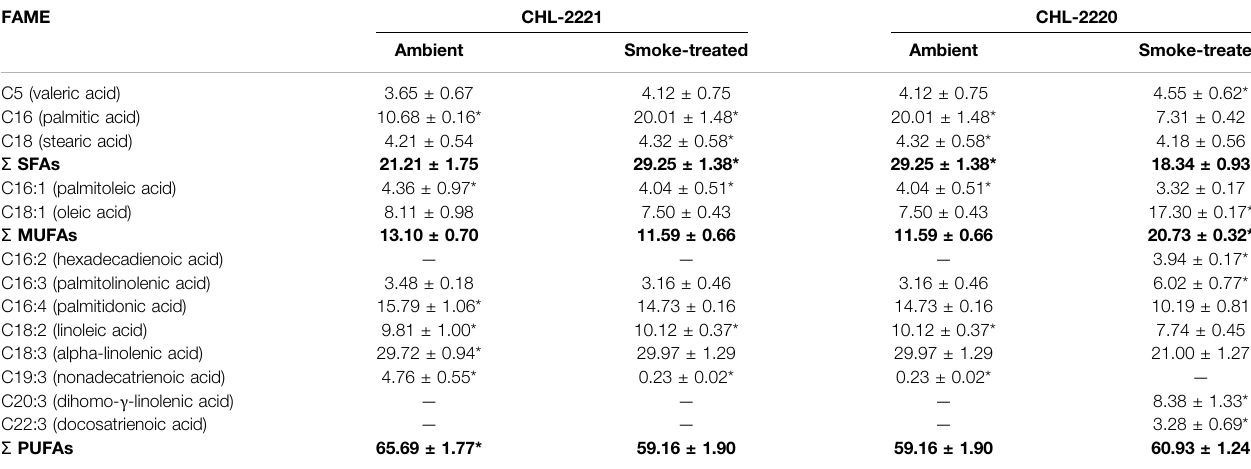
*Indicates a signi fi cant difference between treated cultures and the control. Values are the average ± SD of three replicates, while the “ * ” denotes to substantial differences ( p < 0.05) compared to control. Bold value corresponds to the sum for SFA, MUFA, and